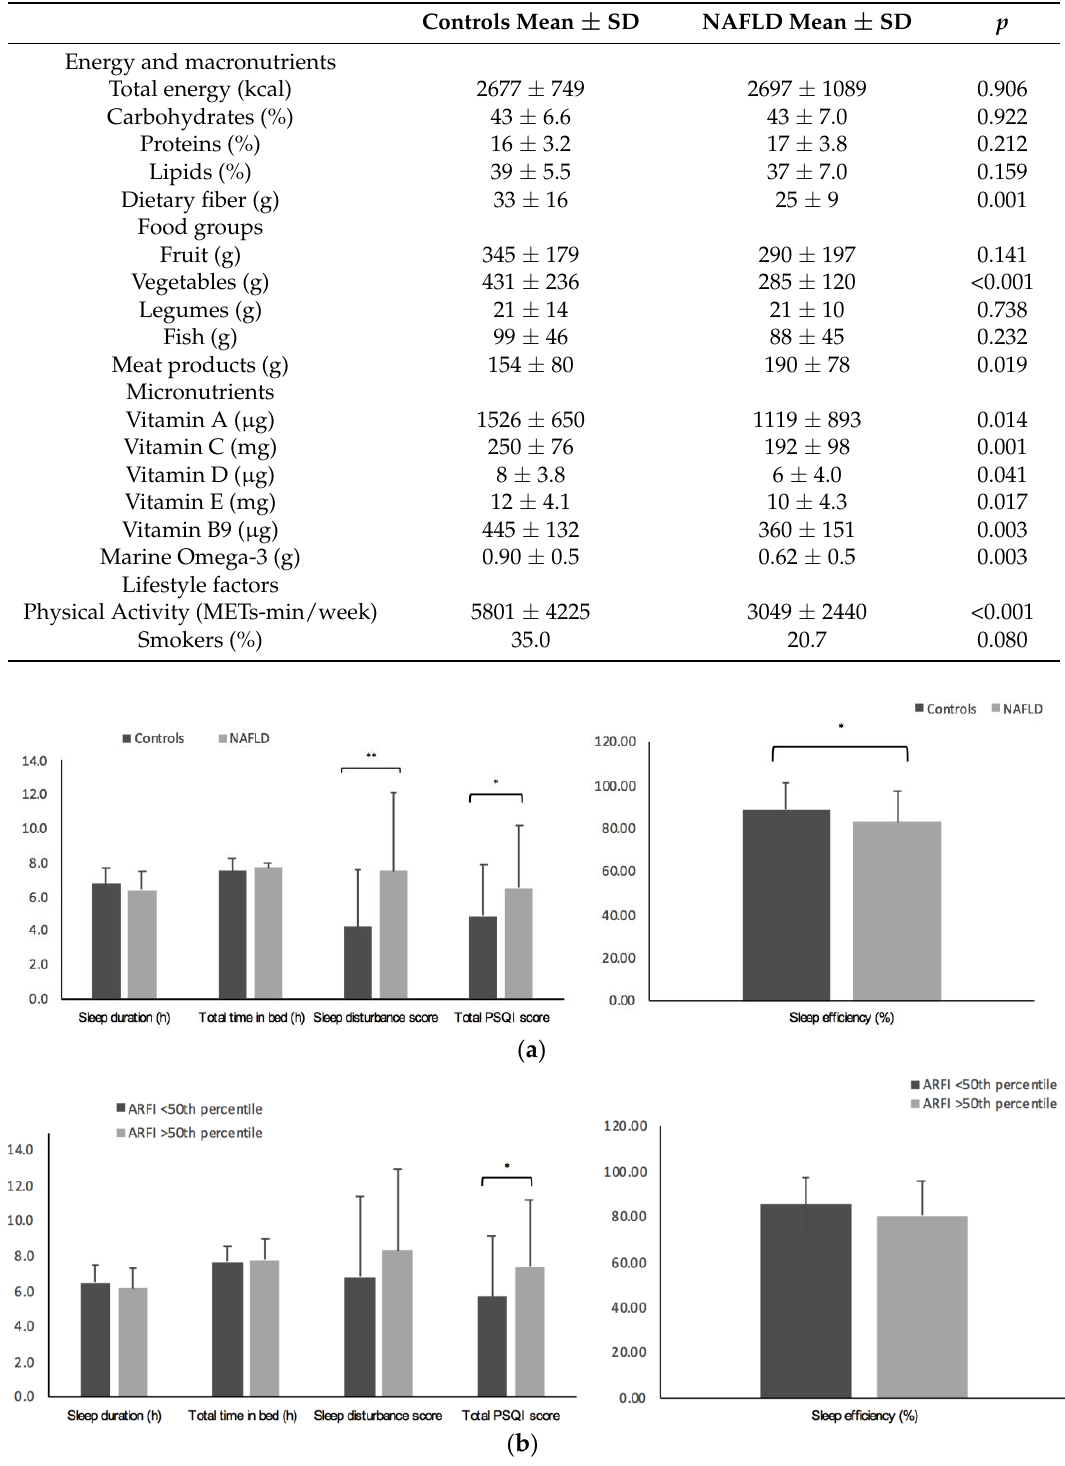
Table 2. Daily nutrient intake and lifestyle factors of participants with ultrasound diagnosed NAFLD ( n = 94) and controls ( n = 40).